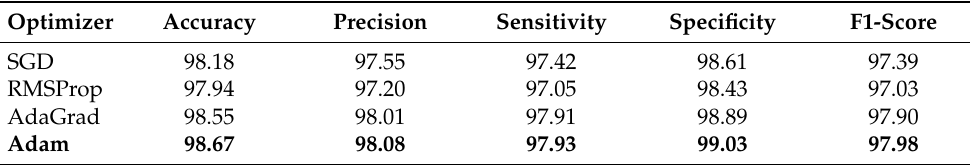
Table 8. Classification results (in %) obtained by various optimizers.